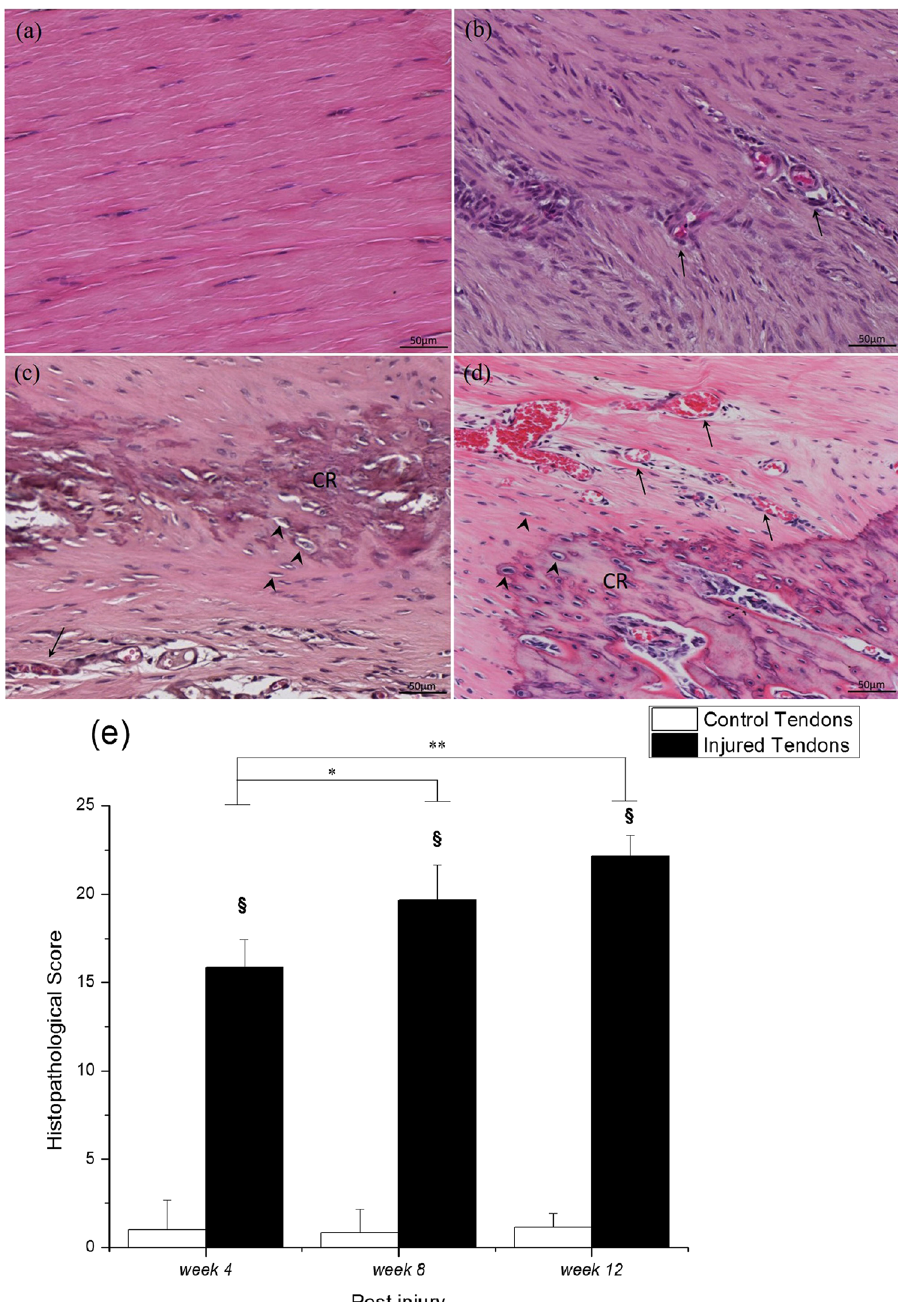
Figure 1. Hematoxylin-eosin staining and histopathological score of Achilles tendons. ( a ) Control tendon, and injured tendons at ( b ) week 4 , ( c ) week 8 , and ( d ) week 12 . The summary of histopathological score along the healing time ( e ). CR, calcified deposits; arrowhead, chondrocyte-like cells; arrow, vascular structure. Bar in H&E = 50 μ m. § compared with the control tendons; * / ** compared within the injured tendons; §/ * p < 0.05, ** p <